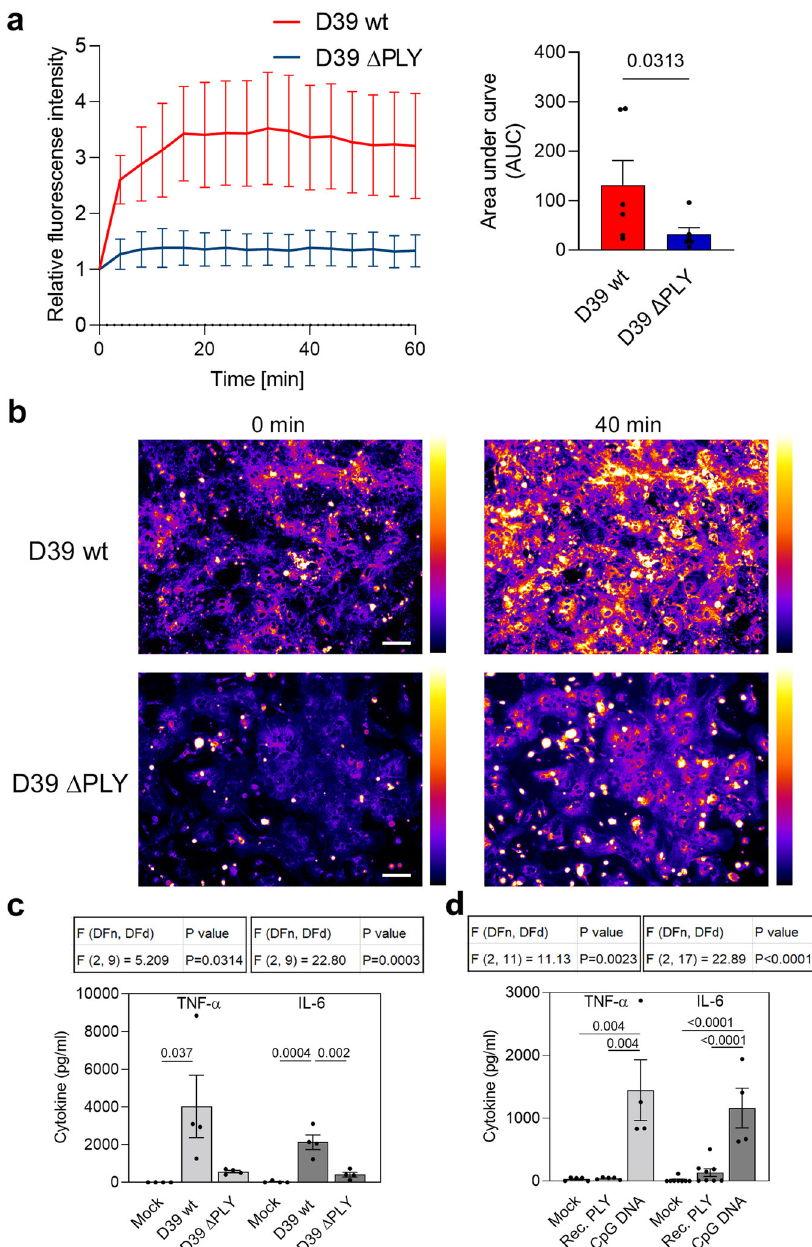
Fig. 2 | Pneumolysin (PLY) is the pro-endocytic and proin fl ammatory factor in Streptococcus pneumoniae lysates but is not proin fl ammatory alone. a The increase in endocytosis (FM 4-64 assay) was nearly completely abolished after exposure to lysates of D39 pneumococci lacking PLY (D39 Δ PLY). Curves are nor- malized to themock-treated controls. Thebar graph representsthe areaunderthe curve comparison. b Representative image of FM 4-64 fl uorescence staining. In these images, the brighter stained cells represent microglia (saturated cells are masked) (pseudocolor Fire LUT (ImageJ)). Scale bar: 100 µ m. c The neuroin- fl ammatoryresponse(TNF- α andIL-6)ofmurinemixedglialcultures24hafterD39